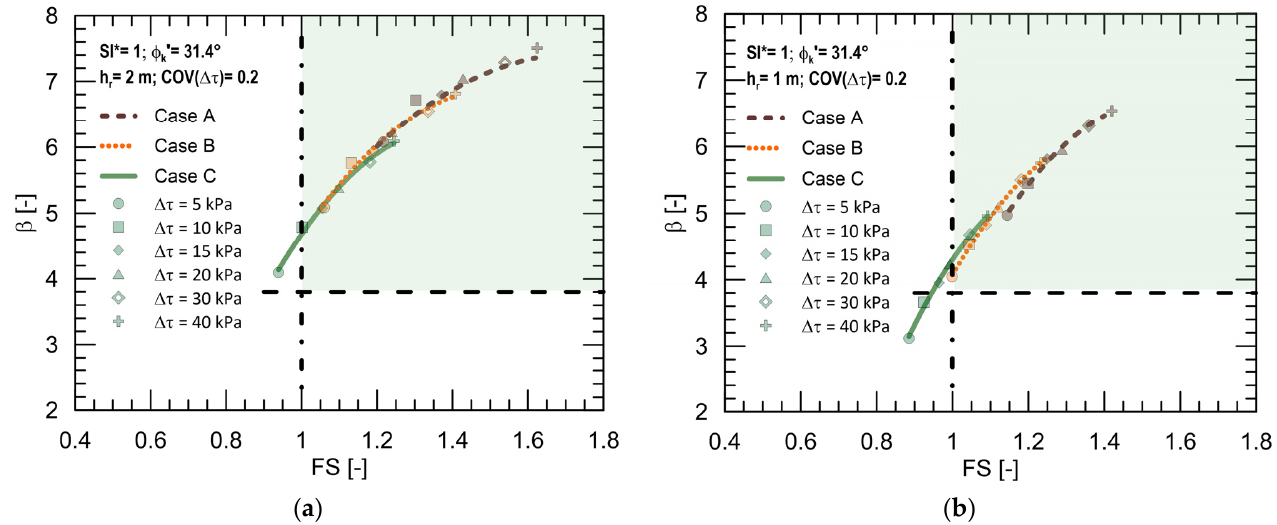
Figure 7. β - FS curves for varying ∆ τ and seismic input, for φ k (cid:48) = 31.4 ◦ and COV ( ∆ τ ) = 20%, in case Figure 7. β ‐ FS curves for varying  τ and seismic input, for ϕ k ′ = 31.4° and COV (  τ ) = 20%, in case of h r = 2 m ( a ) and h r = 1 m ( b ), respectively. of h r = 2 m ( a ) and h r = 1 m ( b ),